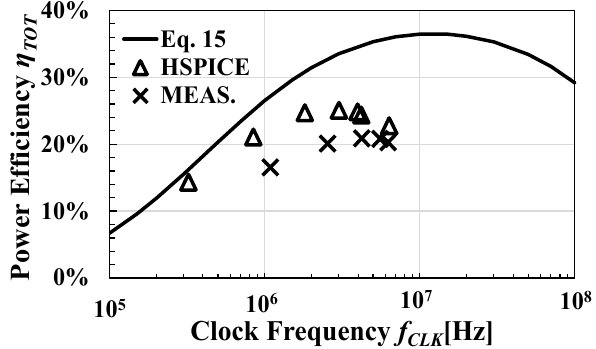
Figure 14. η TOT as a function of f CLK ( V DD = 0.5 V, V OUT = 2 V, f IN = 1 kHz).